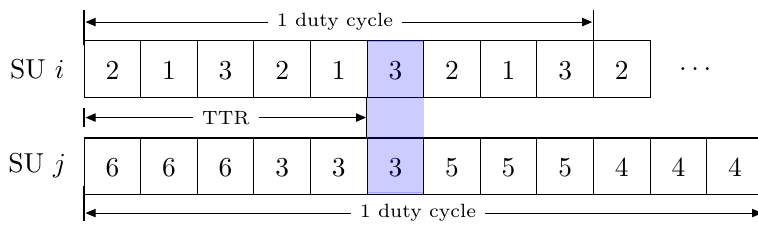
Figure 2. Illustration of the hopping sequences at SUs i and j